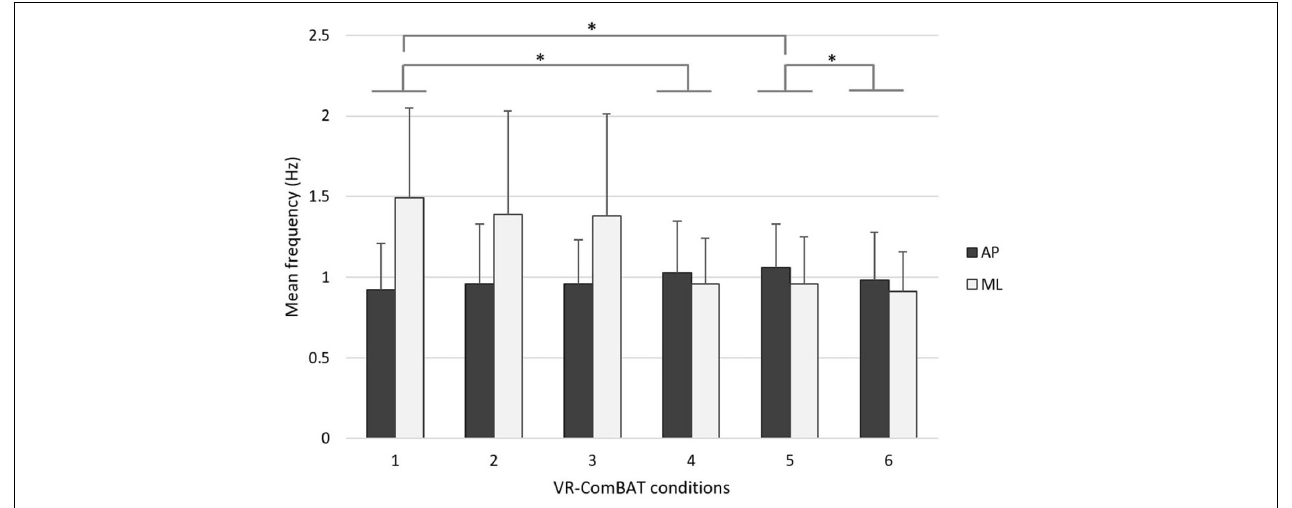
FIGURE 5 | Mean rotational frequency of COP in anteroposterior (black) and mediolateral (gray) directions across the 6 VR-ComBAT conditions. *Significant differences ( p <